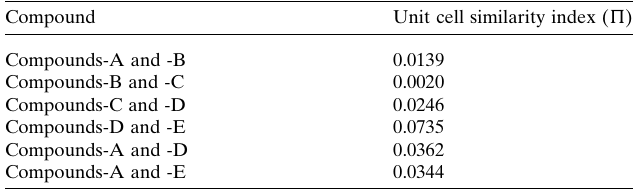
Table 3 Unit-cell similarity index ( (cid:2)